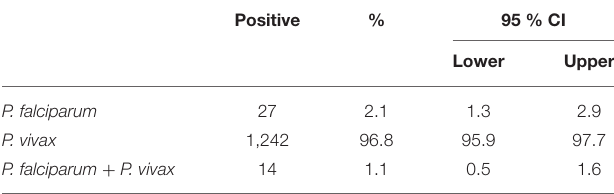
TABLE 2 | Prevalence of malaria infection in Bannu district ( n = 15,650).